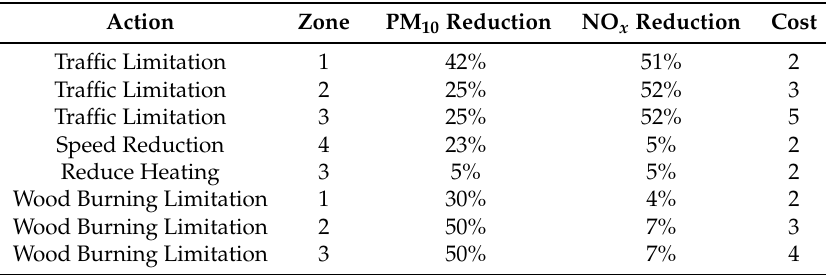
Table 2. Abatement measures